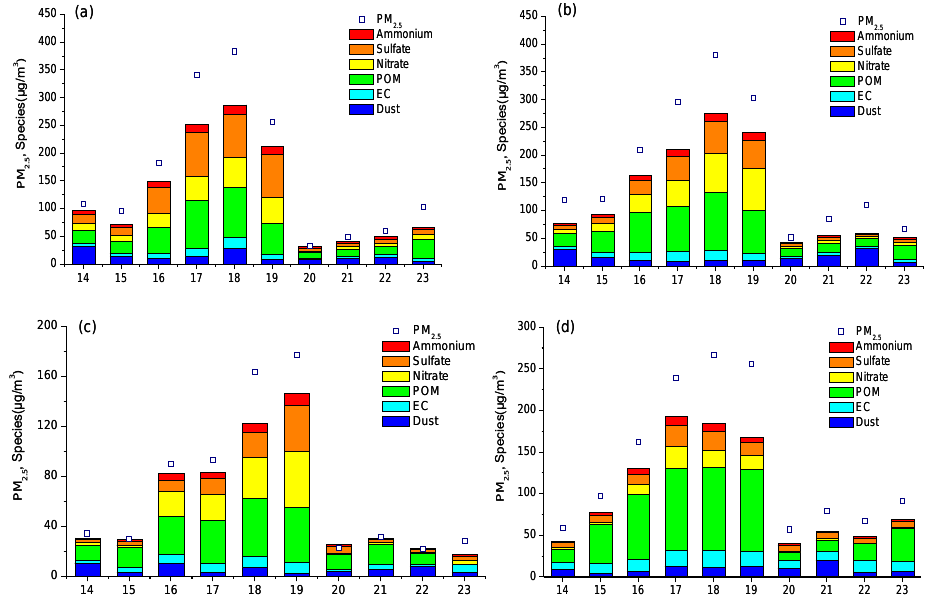
Fig. 6. Variation of concentrations of PM 2 . 5 and chemical species at (a) TJ, (b) BJ, (c) SDZ and (d) CD from 14 to 23 January Fig.6. Variation of concentrations of PM SDZ and (d) CD. 3